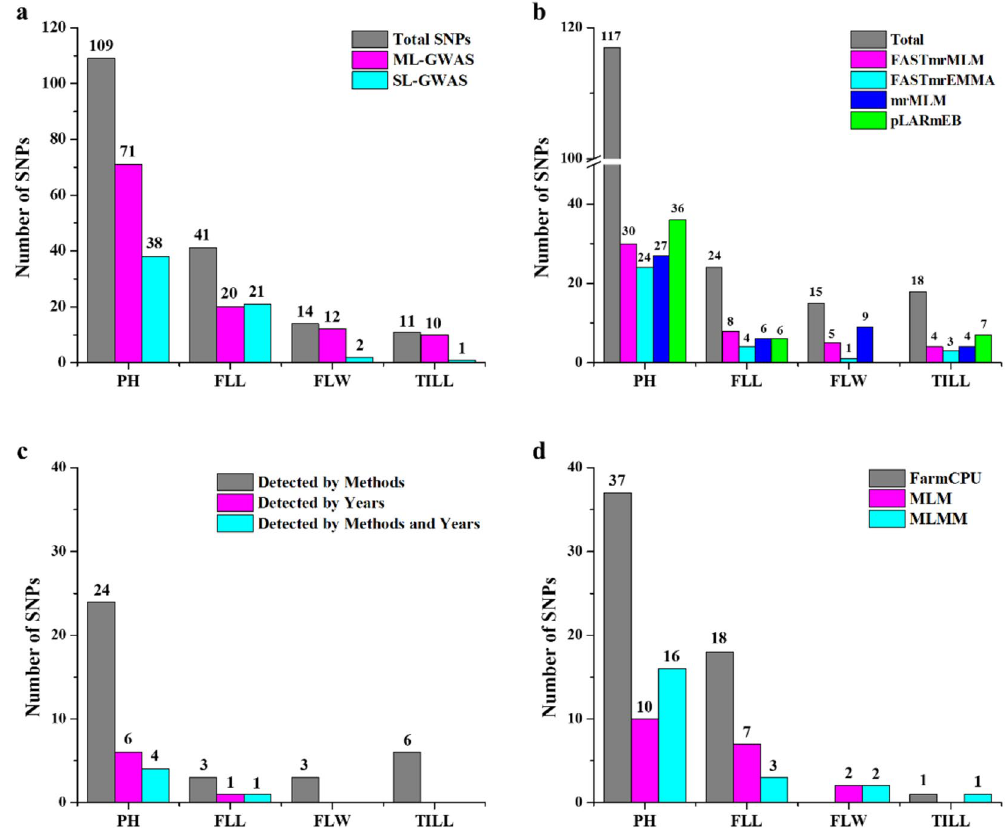
( a ) Significant SNPs detected via ML-GWAS and SL-GWAS methods, ( b ) Significant SNPs detected through four ML-GWAS methods i.e. FASTmrMLM, FASTmrEMMA, mrMLM, and pLARmEB, ( c ) Significant